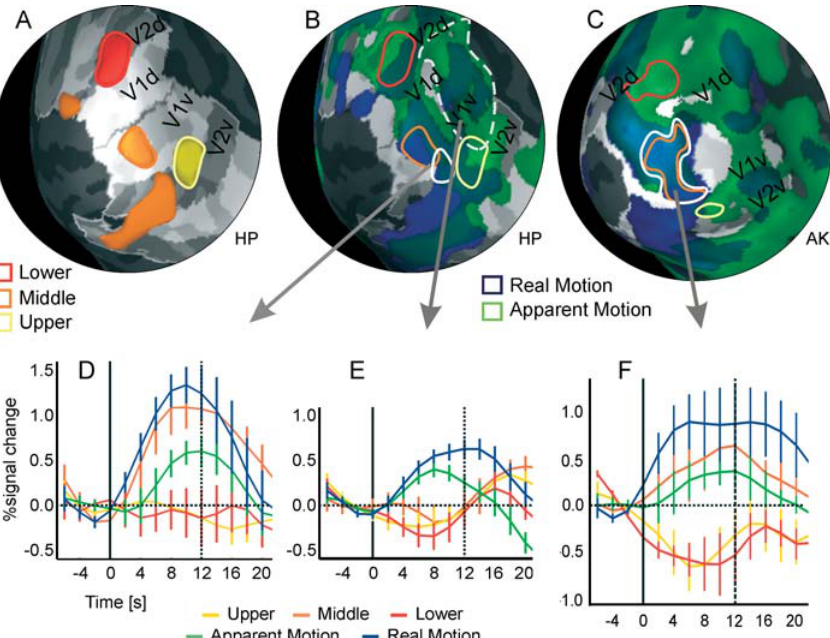
Figure 2. Activation Pattern in V1 for Experiment 1 Medio-posterior view on the inflated left occipital cortex of subject HP (A and B) and subject AK (C). All five subjects are shown in Figure S1. Gray-scale coloring of cortex indicates the extent of retinotopic visual areas (light gray: V1 and V3/VP; dark gray: V2, V4, and V3A) and the gyral pattern (concave surfaces are indicated in darker gray in the respective areas). (A) The cortical representations of the mapping stimuli are marked in color. The maps were obtained by calculating a balanced contrast between the respective mapping condition of interest and the two other mapping conditions (e.g., middle versus upper and lower). The thresholds of t -maps were individually adjusted to obtain patches of comparable size in V1: upper (yellow), t (600) . 9.3; middle (orange), t (600) . 11.9; and lower (red), t (600) . 15.1 (all p ,, 0.001). (B) Cortical activation maps for the apparent-motion (green) and real-motion (blue) condition compared to baseline (apparent motion in V1: t [600] . 3.6, p , 0.0004; real motion in V1: t [600] . 18.6, p ,, 0.001). Cortical representations of the mapping stimuli are indicated by colored outlines taken from (A). The solid white line indicates a patch of significant activation ( t [600] . 3, p , 0.003) for the following conjunction of contrasts, which represents the ideal activation pattern: (middle . upper) and (middle . lower) and (apparent motion . upper) and (apparent motion . lower). The dashed white line marks a peripheral region in V1 with significant activation in response to apparent motion and real motion. (C) Same as (B) for subject AK. The white region with the optimal response pattern overlaps largely with the representation of the middle stimulus (in orange; see Figure S1 for details). (D) Event-related BOLD signal change for subject HP plotted over time from the patch outlined by the solid white line in (B) (solid black line indicates stimulus onset, dotted line stimulus offset). (E) Event-related BOLD signal change of the apparent-motion-activated (green) region from the eccentric parts of V1 outlined by the dashed white line in (B) (solid black line indicates stimulus onset, dotted line stimulus offset). This eccentric region responds to real motion and apparent motion but not to the middle stimulus. (F) Same as (D) for subject AK. Error bars correspond to standard errors of the mean. DOI: 10.1371/journal.pbio.0030265.g002